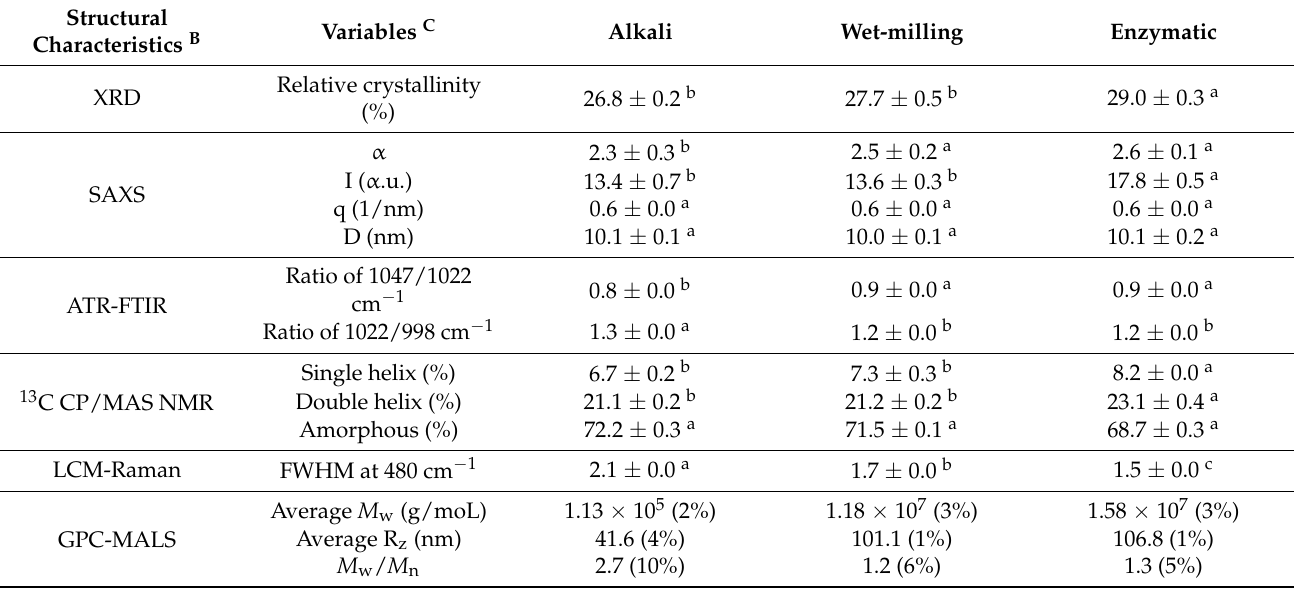
Table 2. Multi-scale structure and molecular weight changes in quinoa starch isolated by three different methods (alkali, wet-milling, and enzymatic) A